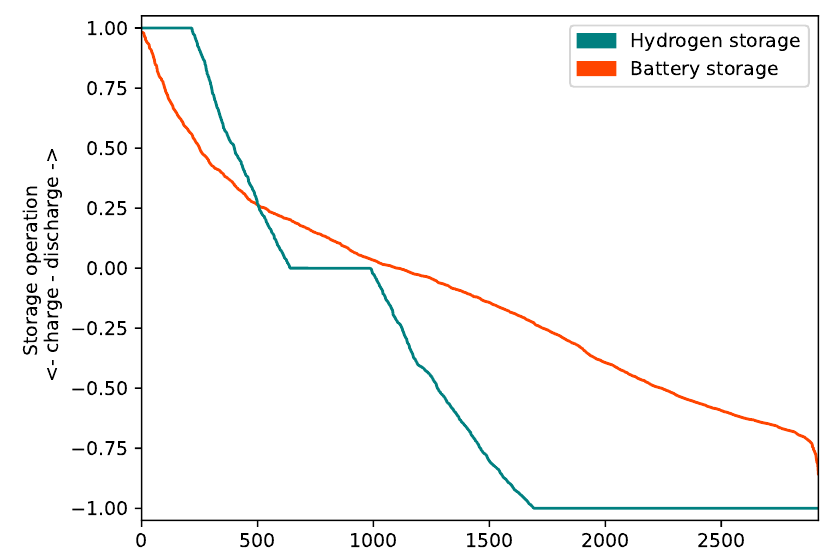
Figure 5. Sorted annual duration curve of the operation mode by storage technologies. Negative values indicate storage charging, positive values indicate discharging. The blue line shows the hydrogen storage, the red line illustrates battery storage units which have been accumulated for better visualisation.